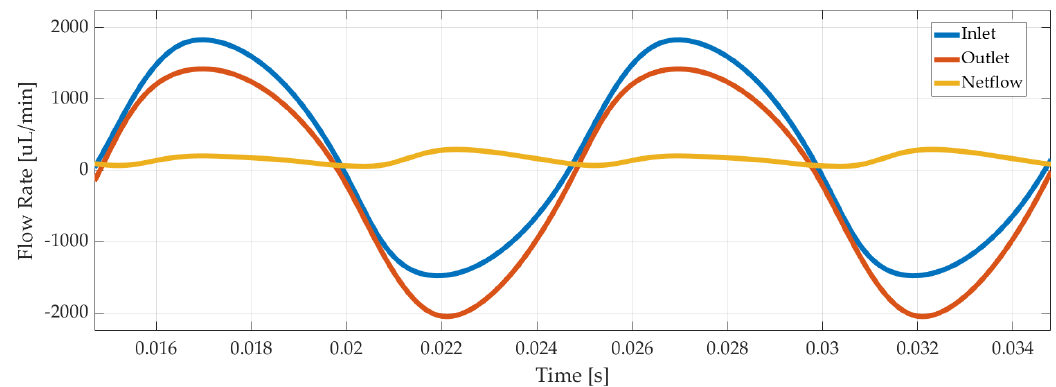
Figure 7. Numerical simulation results of inlet, outlet, and net flow rate of the piezoelectric pump.